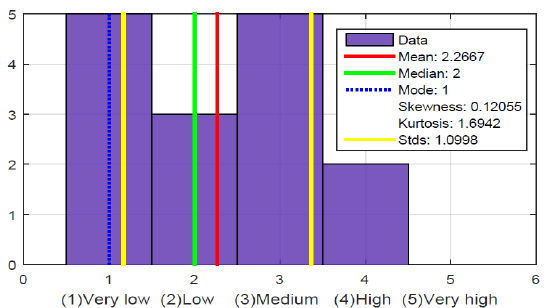
Figure 17. How much do you understand when you listen to a soccer commentator during a match transmission?